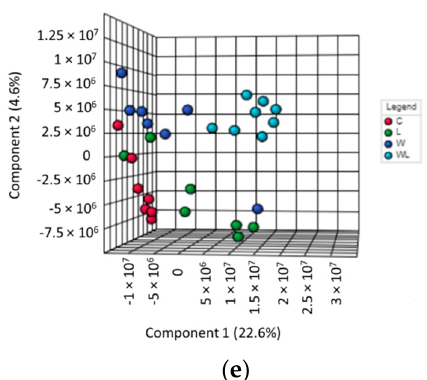
Figure 2. Results obtained from gastrocnemius muscle samples from all experimental groups: ( a ) gastrocnemius muscle polar extract PLS–DA plot score; gastrocnemius muscle polar extract identified metabolites, as normalized concentrations ( µ M); ( b ) 2-deoxyuridine; ( c ) nicotinurate; ( d ) NAD + and NADP + ; ( e ) muscle non-polar extract PLS–DA plot score. Legend: C, Control group ( n = 7–8); W, Tumor-bearing group ( n = 7); L, Group without tumors and with a maternal leucine-rich diet ( n = 7–8); WL, Tumor-bearing group with a maternal leucine-rich diet ( n = 8). For more details, see Material and Method section. a , p < 0.05 for statistical di ff erence compared to C group; b , p < 0.05 for statistical di ff erence compared to L